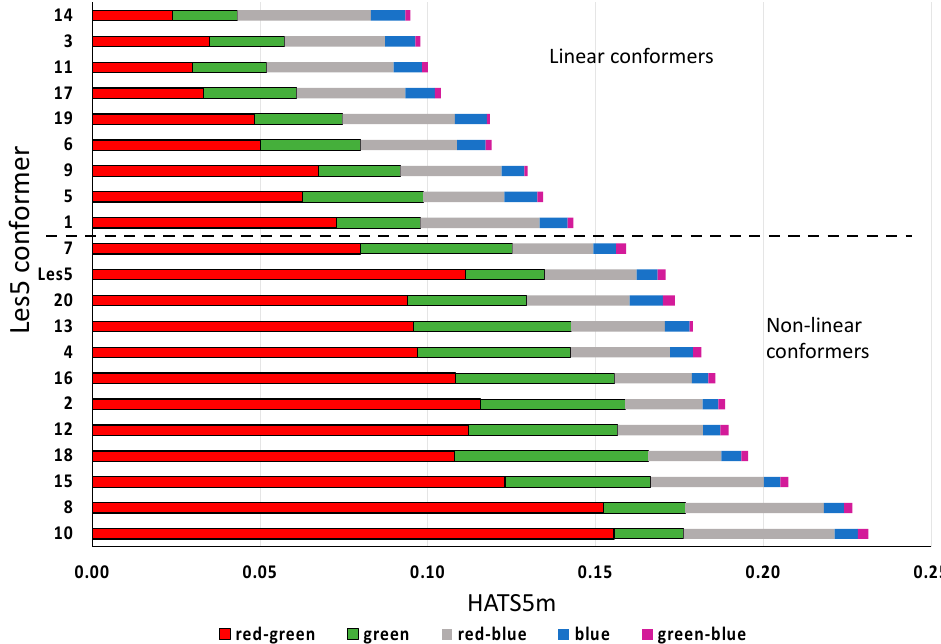
Figure 14. The contributions of 20 conformers of Les5 (Les-3834) to the HATS5m value. They are arranged in ascending order of the HATS5m value.